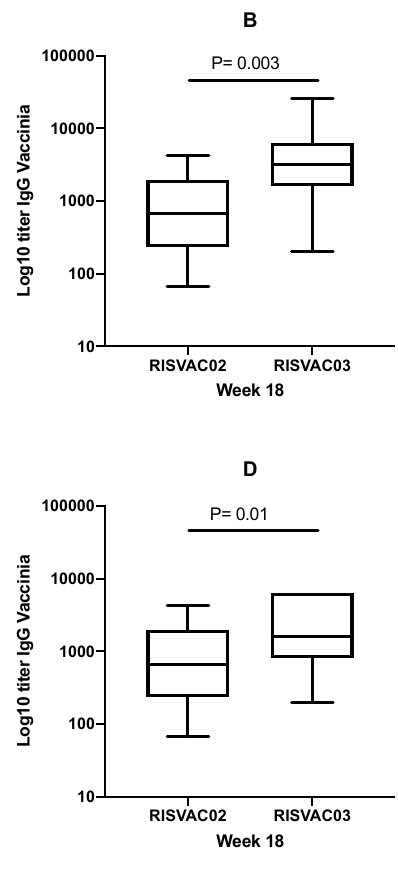
Figure 3. Binding antibodies (IgG titers) against vaccinia virus in RISVAC02 compared to RISVAC03. ( A ) at weeks 8 and 6, respectively; ( B ) at week 18; ( C ) at weeks 8 and 6, respectively, only including participants without previous exposition to vaccinia virus; and ( D ) at week 18, only including participants without previous exposition to vaccinia virus.